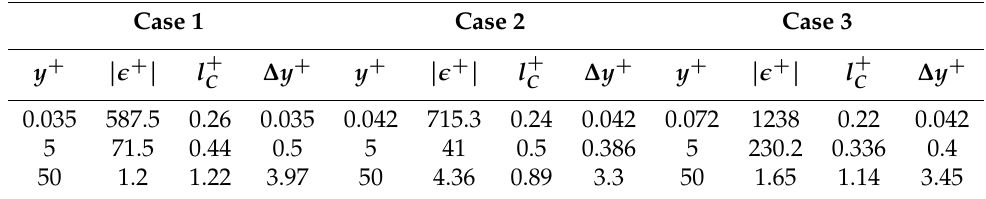
Table A3. Obukhoff–Corrsin length scales at x / D = 0.5.